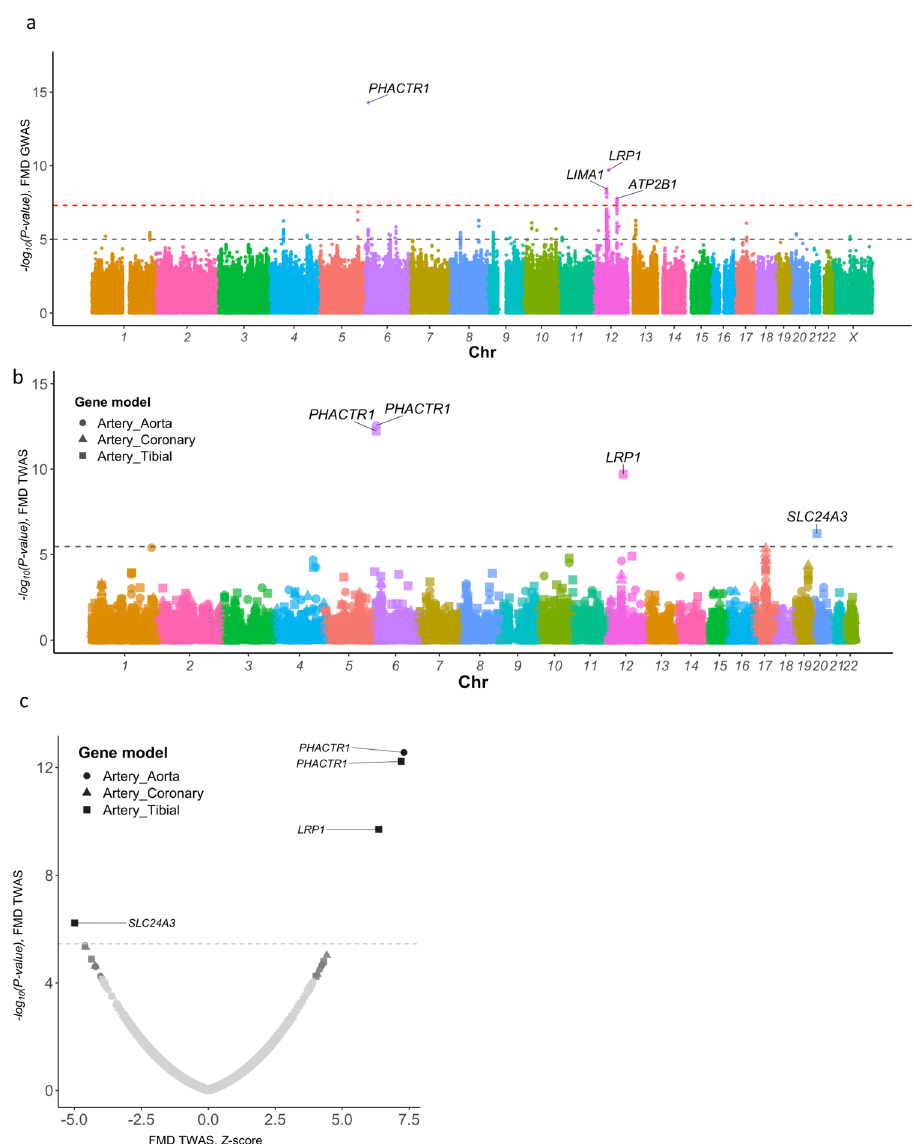
Fig. 1 SNP-based and transcriptome-wide association analyses. a Manhattan plot representation of SNP-based association analysis in FMD. − log 10 of association P value (from a two-sided Wald test) is represented on the y- axis, genomic coordinates on the x- axis. Name of lead SNPs with P value ≤ 5 × 10 − 8 are indicated. b Manhattan plot representation of Transcriptome-wide association analysis (TWAS) in FMD with tibial artery (square dots), aorta (round dots) and coronary artery (triangle dots) gene expression models. − log 10 of association P value is represented on the y- axis, genomic coordinates on the x- axis. Name of genes with Bonferroni corrected P value ≤ 0.05 are indicated. c Volcano plot representation of FMD TWAS. TWAS Z - score is represented on the x- axis, − log 10 of TWAS P value on the y- axis. The dashed line represents the threshold for signi fi cance adjusted for multiple testing. Name of genes with Bonferroni adjusted P value < 0.05 are (Supplementary Table S5). TWAS in tibial artery revealed note, SLC24A3 showed nominal signi fi cance in the gene-based analysis ( P = 2 × 10 − 3 ), and it overlaps two independent and suggestive signals (lead SNP: rs2424245, P = 4.0 × 10 − 6 , sec- ondary SNP: rs6046121, P = 4 × 10 − 4 , correlation r 2 < 0.01, Supplementary Fig. S4). FMD risk alleles of both variants asso- ciated with lower SLC24A3 expression in tibial artery and aorta (Supplementary Fig. S4).